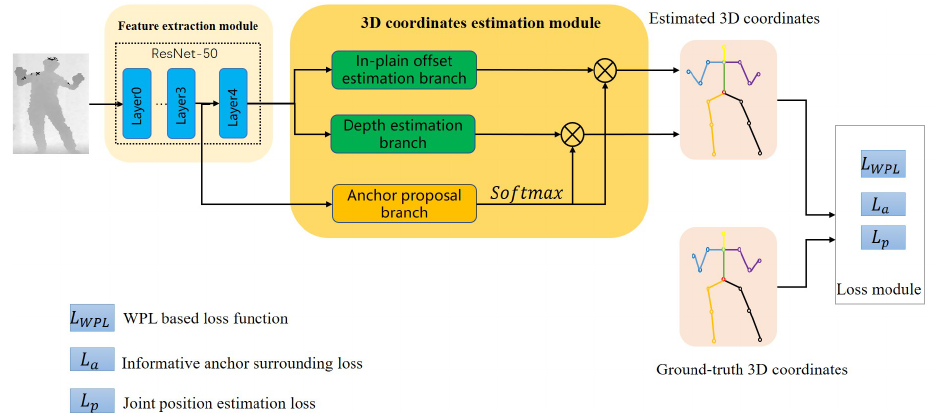
Figure 2. The framework of the proposed method is based on A2J. The feature extraction module first extracts the feature of the input depth image. Then, the 3D coordinates estimation module estimates the 3D positions of joints using the extracted features. Finally, the estimated and the ground-truth 3D coordinates are used to calculate the global-to-local WPL-based loss, informative anchor surrounding loss, and joint position estimation